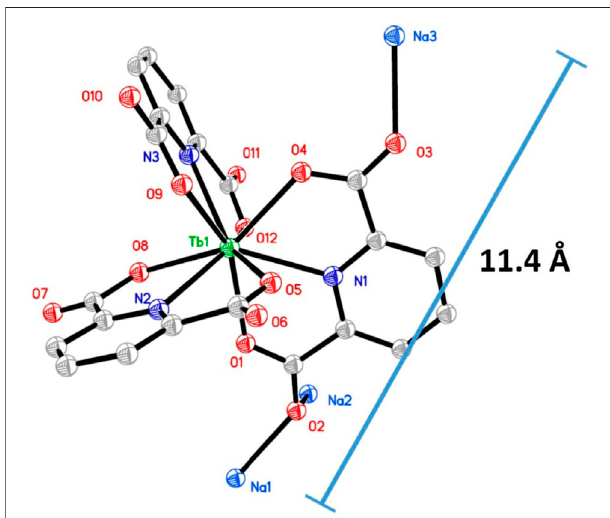
FIGURE 1 | Single crystal structure of Na 3 Tb(PDA) 3 , H atoms and water molecules are omitted for a clear